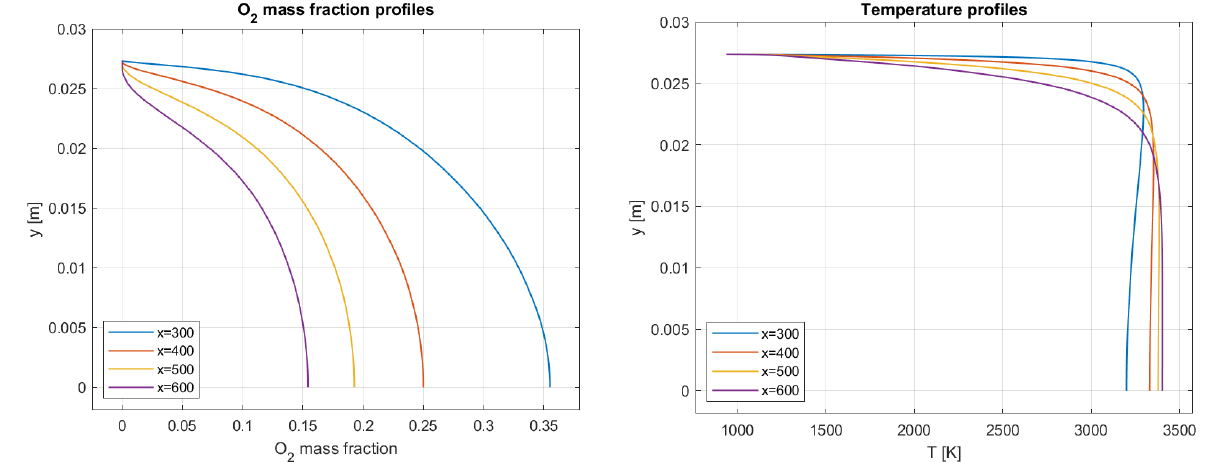
Figure 10. O 2 mass fraction ( left ) and temperature ( right ) profiles for Test 7.